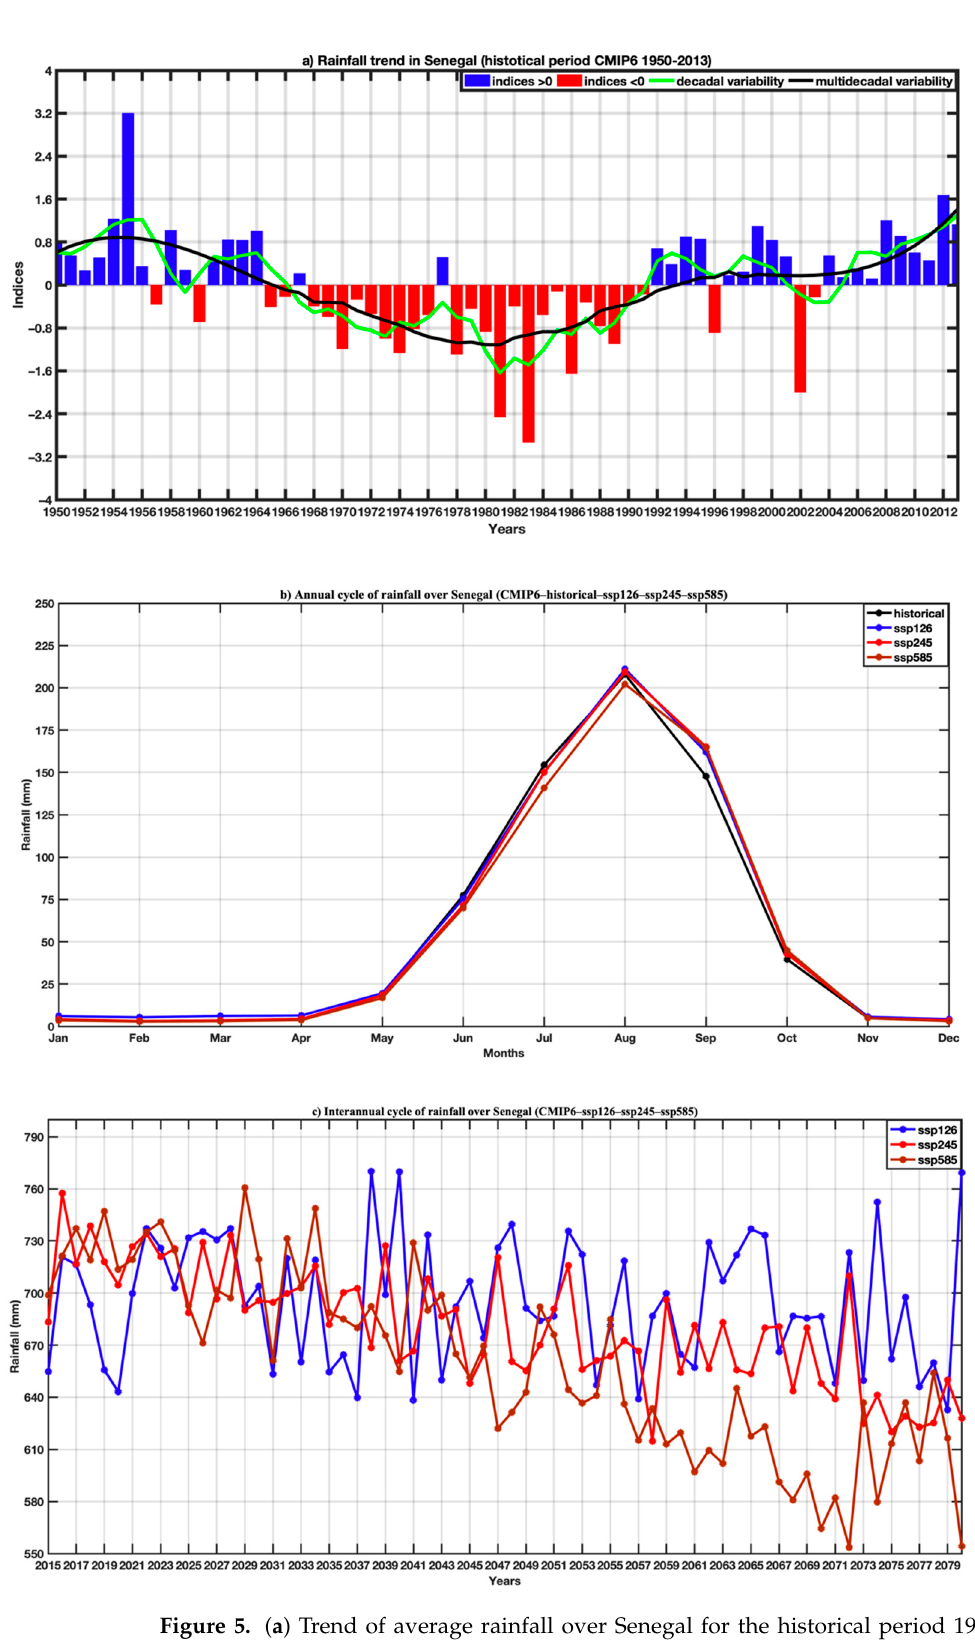
Figure 5. ( a ) Trend of average rainfall over Senegal for the historical period 1950–2013 (overall average of CMIP6 models) highlighting interannual variability, decadal and multi-decadal variability, ( a , b ) respectively, annual cycle and interannual variability rainfall in Senegal with historical data (1950–2014), and ( c ) projections (2015–2080) for the SSP126, SSP245, SSP585 scenarios of the CMIP6.